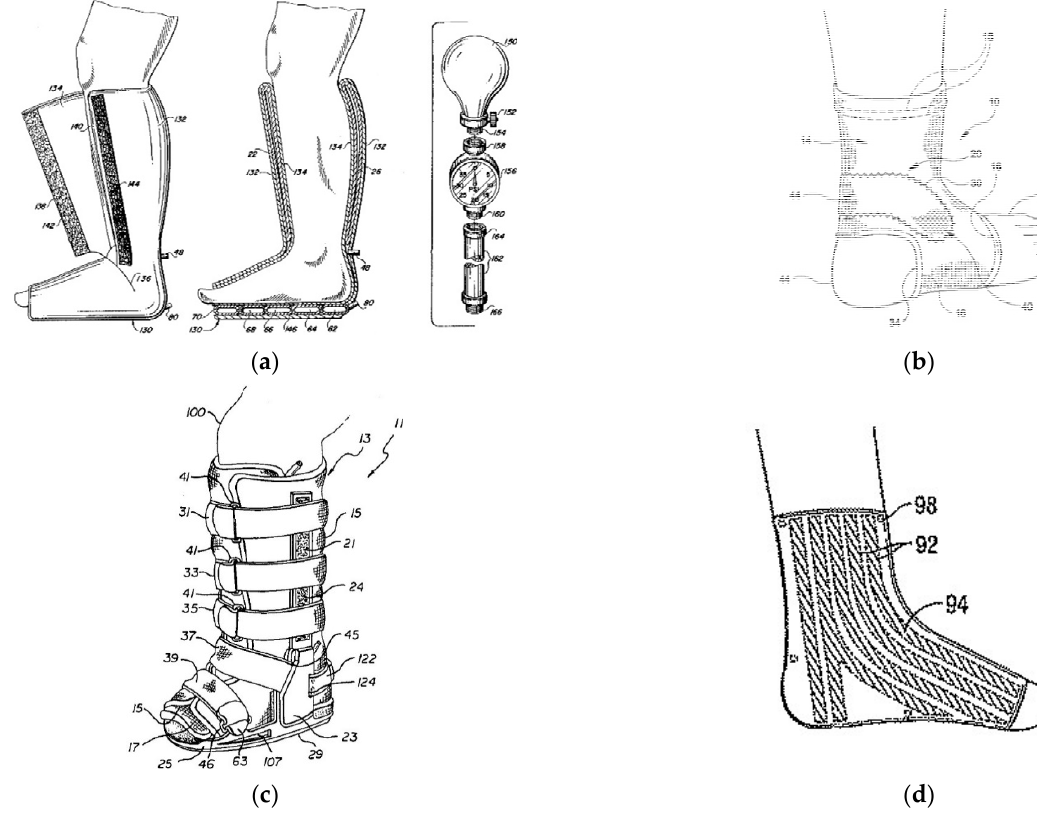
Figure 11. Patents of Brace: ( a ) Adjustable Pressure Cast for orthopaedic injuries [57], ( b ) Therapeutic Elastic Body Support [58], ( c ) Walker with Open Heel [59], and ( d ) Transformable Orthopaedic Brace for injury prevention [60].